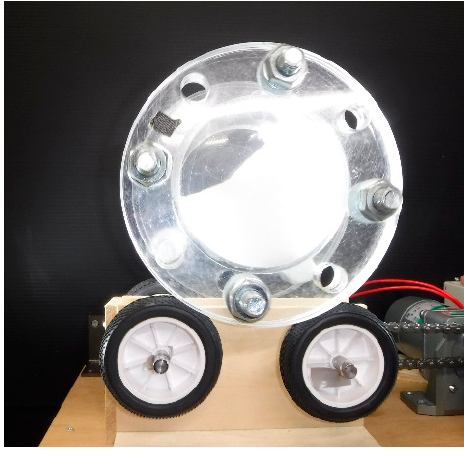
Figure 1. Rotating drum used in this study. An acrylic cylindrical container is set on a turntable.